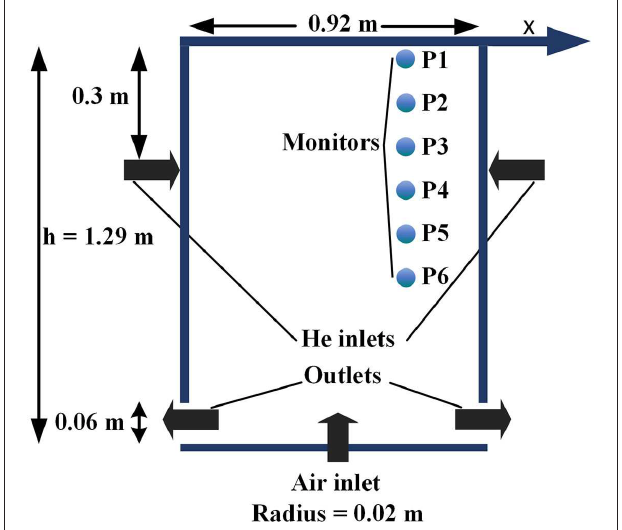
FIGURE 1 | Sketch of the experimental layout.